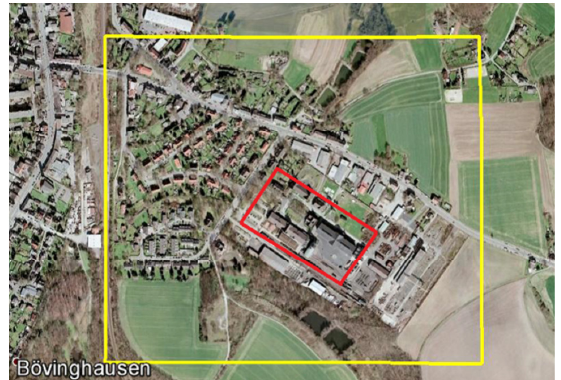
Figure 2. Area test on the Zeche Zollern Museum (Dortmund). - Terrestrial images : Three different buildings (“Lohnhalle”, “Pferdestall” and “Verwaltung”) were imaged with the same